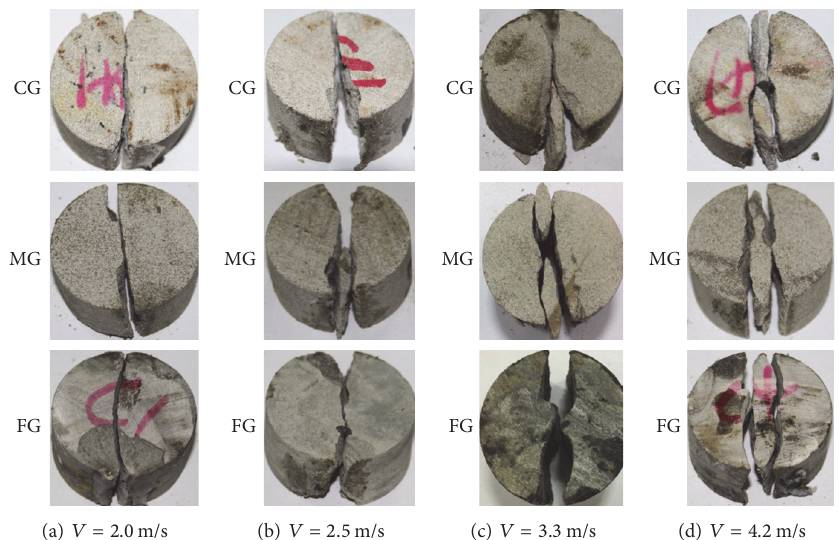
Figure 15: Failure modes of sandstone samples during dynamic Brazilian tests under different loading